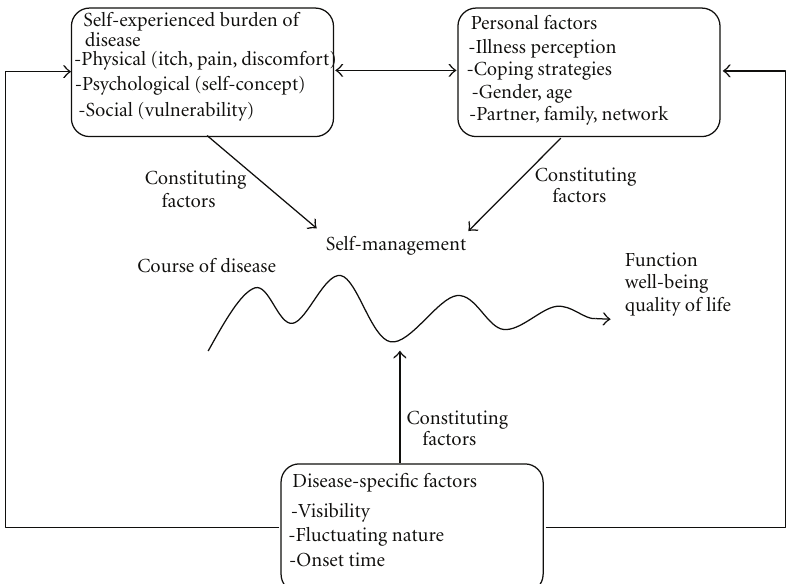
Figure 2: High-impact factors for patient self-management of psoriasis in daily